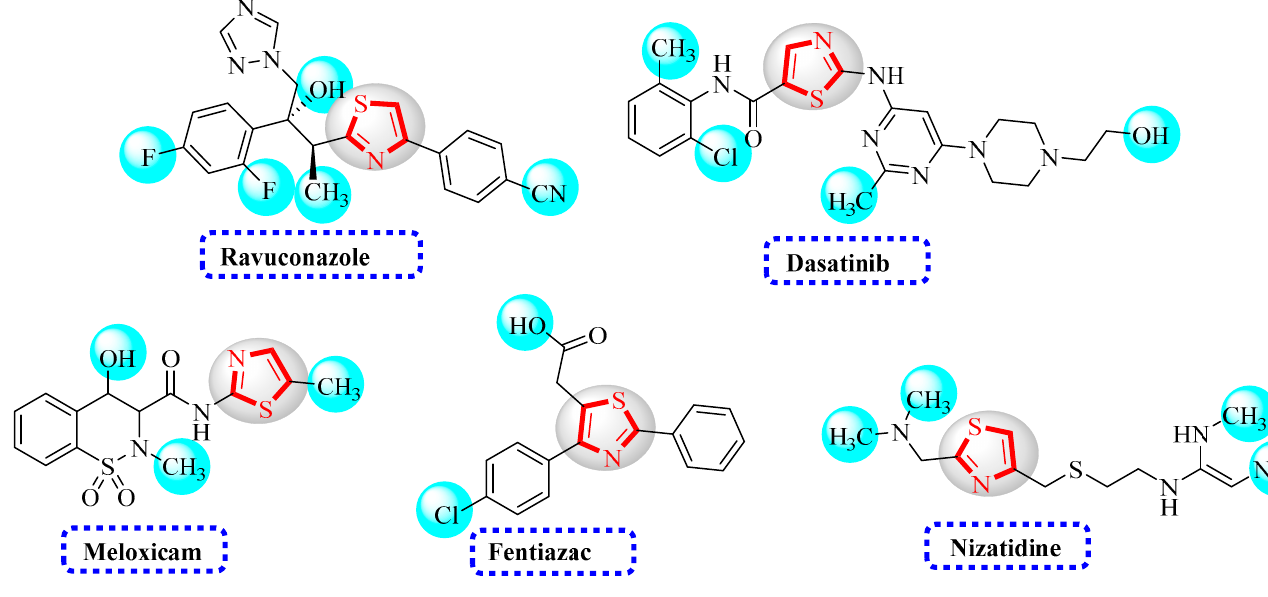
Figure 1. Thiazole-containing